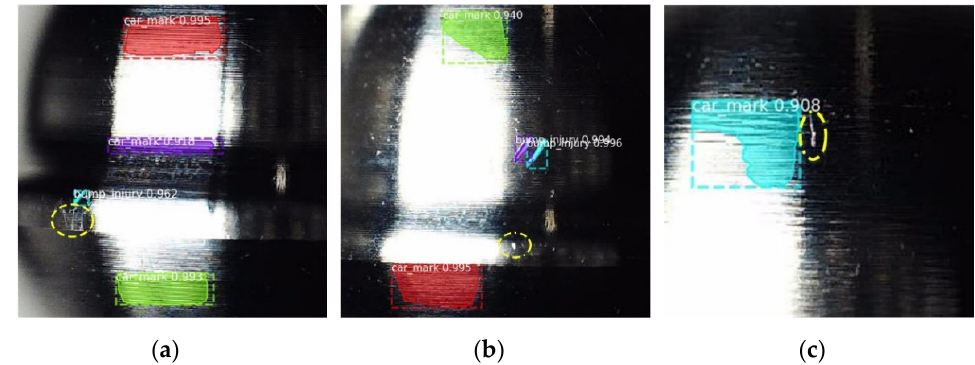
Figure 5. Automobile engine part defect detection results of the Mask R-CNN. ( a ) missing defect (yellow circle); ( b ) missing defect (yellow circle); and ( c ) missing defect (yellow circle).